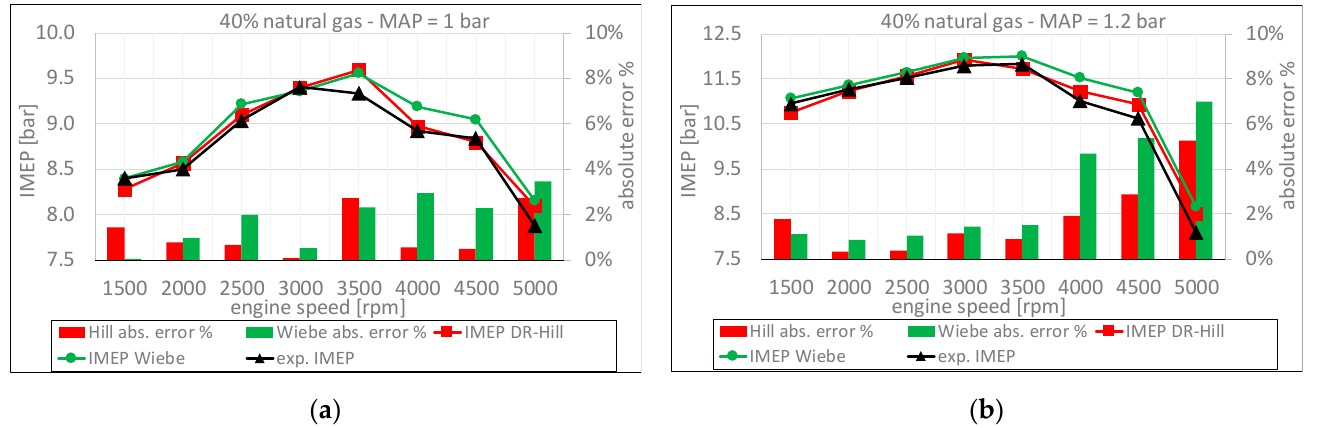
Figure 2. comparison between the experimental and simulated IMEP; 40% NG fuel mixture. ( a ) Figure 2. Comparison between the experimental and simulated IMEP; 40% NG fuel mixture. MAP = 1 bar. ( b ) MAP = 1.2 bar. ( a ) MAP = 1 bar. ( b ) MAP = 1.2